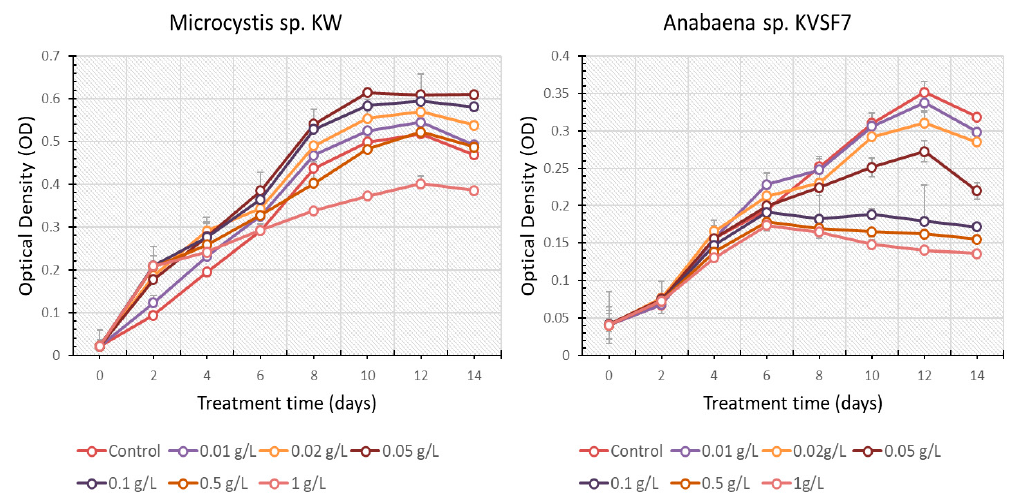
Figure 1. OD values at 680 nm of M.S. culture ( A ) and A.S. culture ( B ) where MgAC concentrations (0, 0.01, 0.02, 0.05, 0.1, 0.5, and 1.0 g/L) are treated in culturing for 0, 2, 4, 6, 8, 10, 12, and 14 days. The standard deviations of the mean ( n = 3) are represented by the error bars. A p < 0.05 value is considered to represent significant difference.